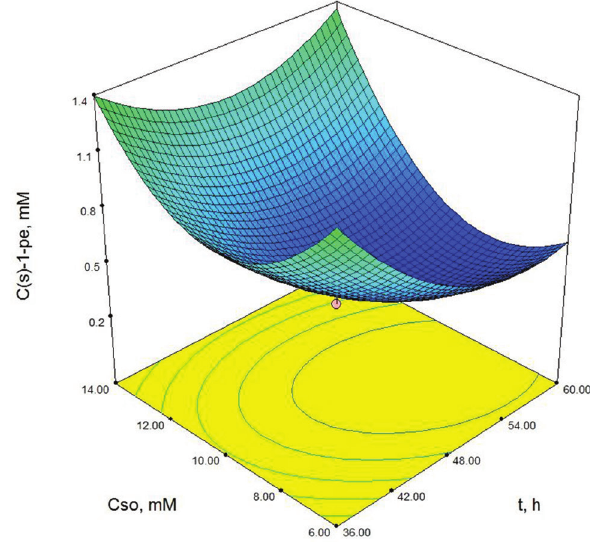
Figure 2: Contour-plot of ( S )-1-phenylethanol concentration: The effect of time and initial substrate concentration. Other variable is = 30 mM, C = 150 mg/mL. held at zero level. C g b